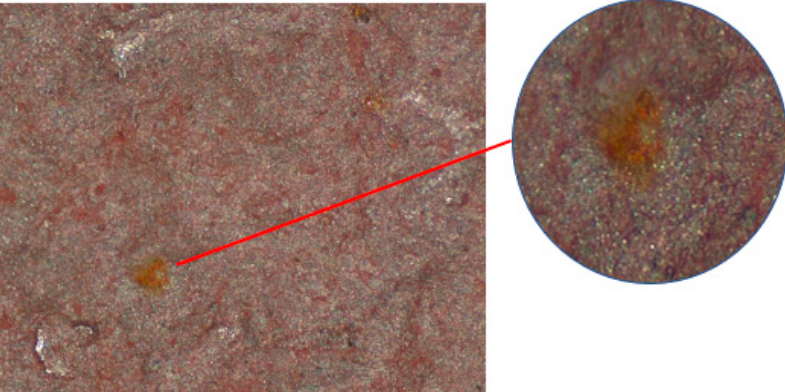
Figure 15. Rust spots on the surface of the no-WBM specimen with a primer thickness of 50–80 μ m.